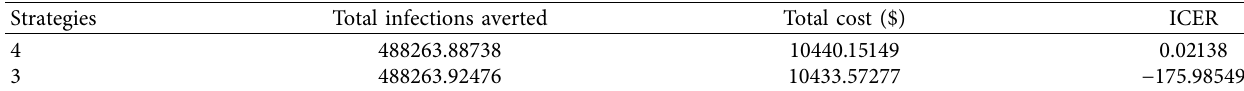
Table 5: Comparing cost and beneft of strategies 3 and 4.